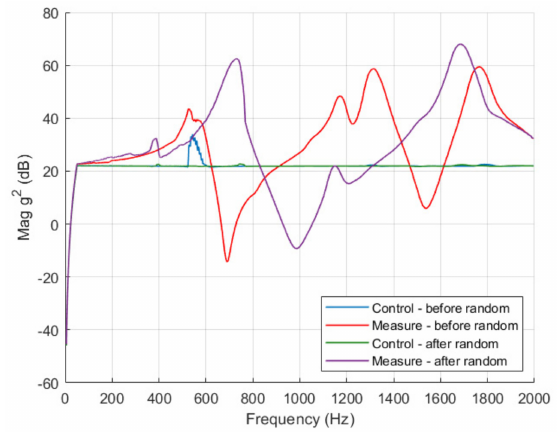
Figure 14. Resonances before and after tests on z axis, AISI 316 spindle.